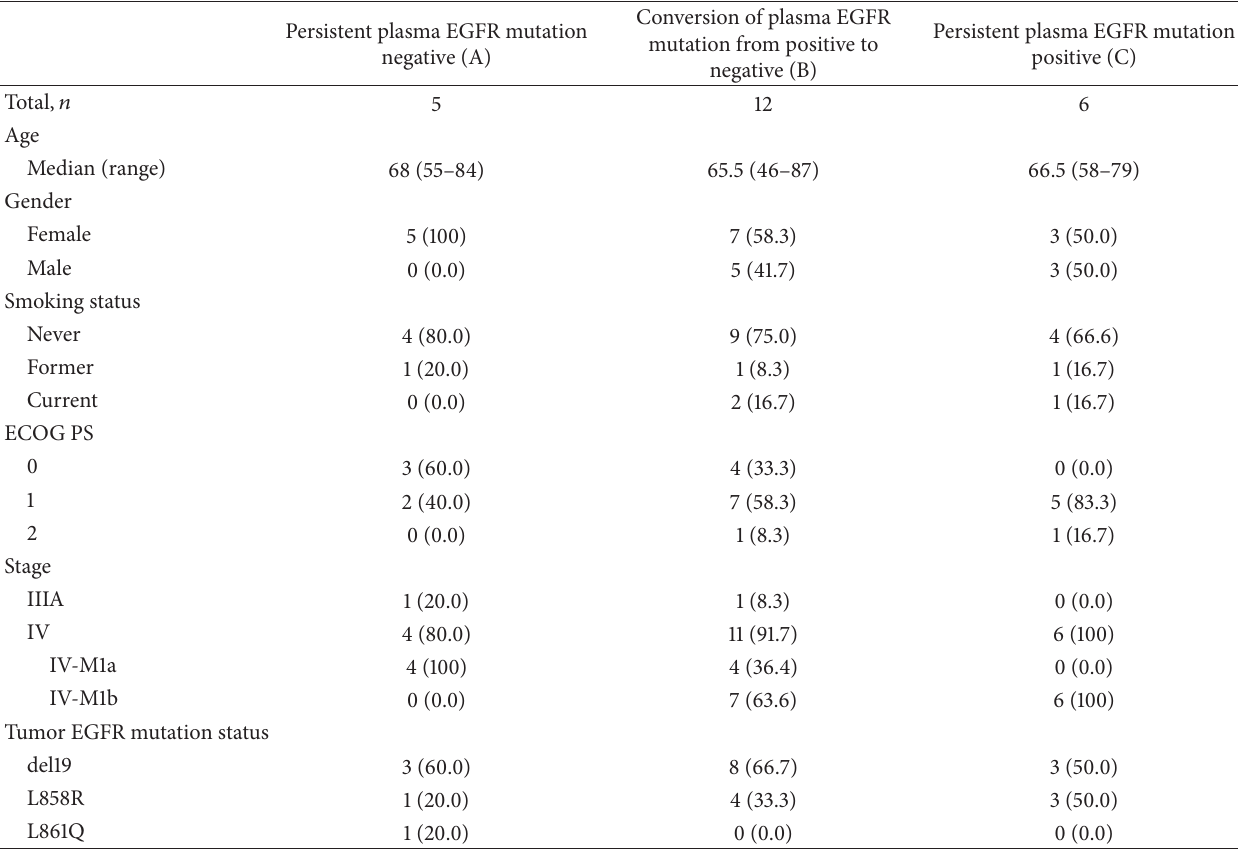
Table 4: Characteristics of patients with alteration of the EGFR mutation status after EGFR-TKI